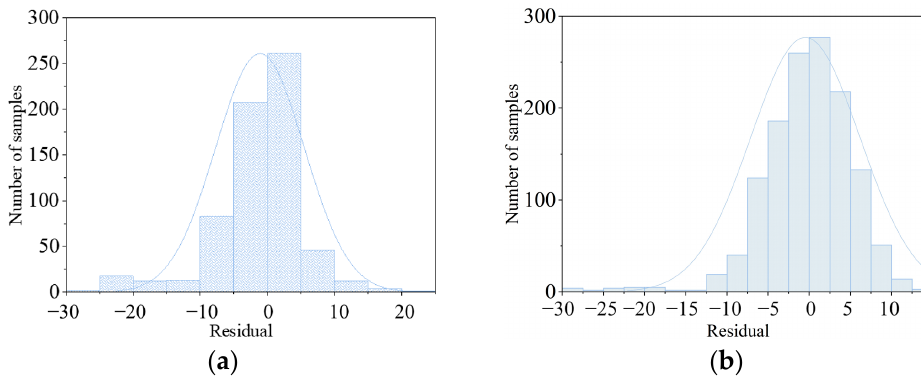
Figure 10. Residual statistics graph. ( a ) Guangzhou terminal area; ( b ) Wuhan terminal area.